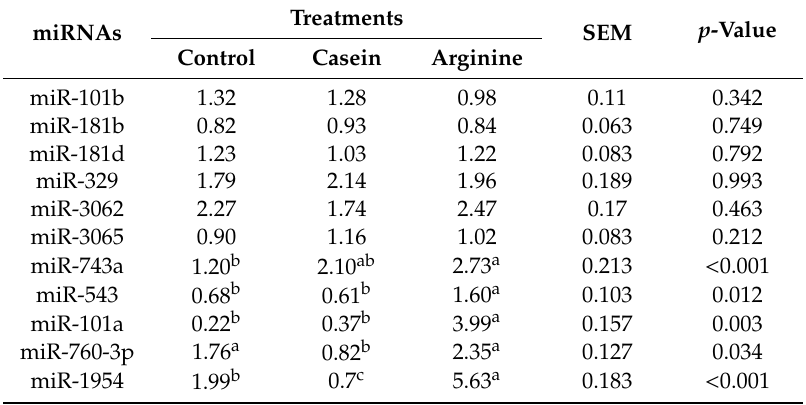
Table 6. Expression of miRNA screened from PicTar and TargetScan databases in bovine mammary epithelial cells in